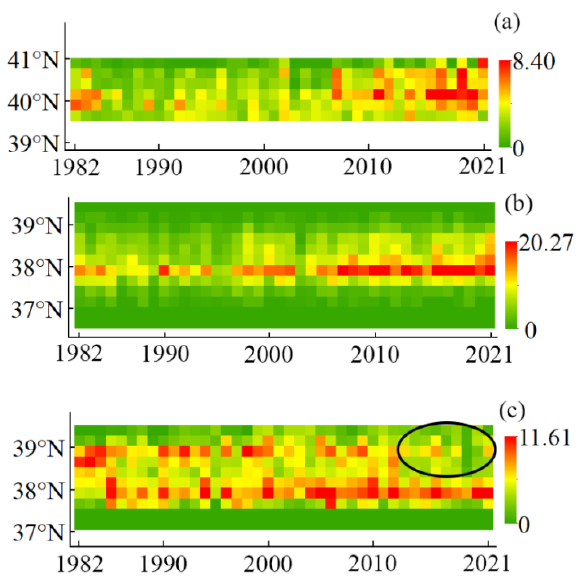
Figure 9. Hovmöller diagram of the annual averaged FP of front in the BS (( a ) LDBF; ( b ) BLBF; ( c ) BHF; black ellipse, areas of reduced front frequency).